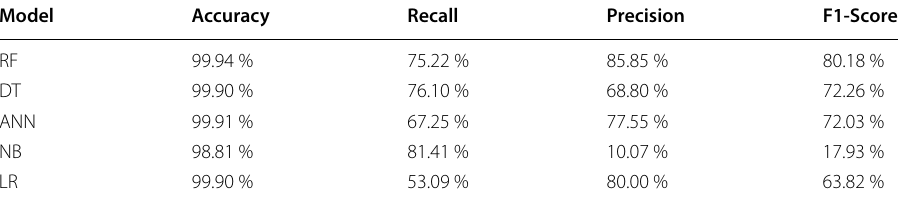
Table 4 Classification results for v 3